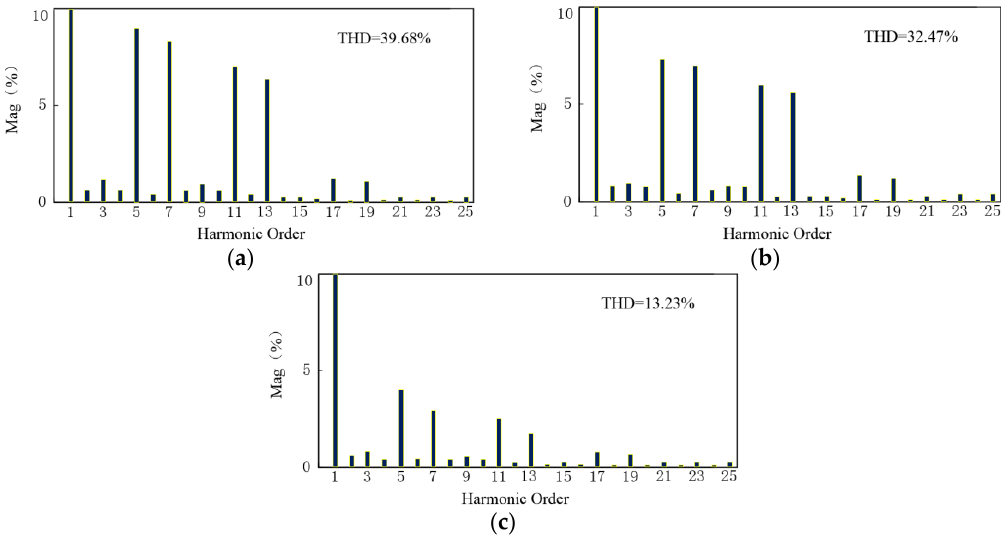
Figure 16. Experimental results of the stator current frequency spectrum of the PMSG with different impedance-source topologies. ( a ) With Z-source inverter; ( b ) With quasi-Z-source inverter; ( c ) With half quasi-Z-source inverter.